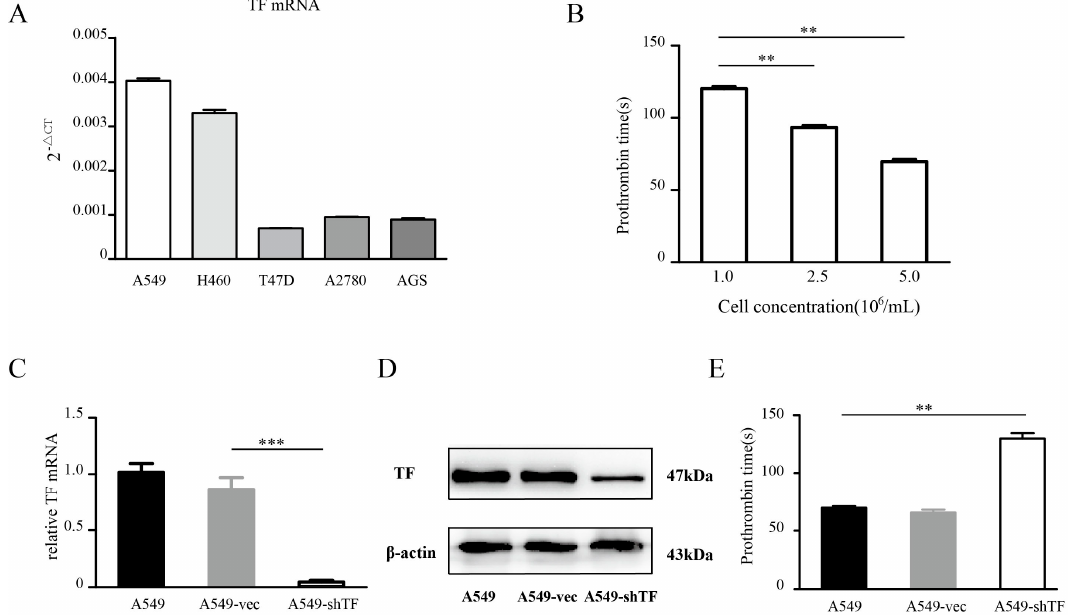
Figure 1. Quantification of tissue factor (TF) and the procoagulant activity of tumor cell. ( A ) TF mRNA was measured in human lung adenocarcinoma cell line A549, breast cancer cell line T47D, ovarian cancer cell line SKOV3, and gastric adenocarcinoma cell line AGS using real-time Polymerase chain reaction (rt-PCR) ( n = 3); ( B ) A549 cells in a series of cell concentrations were tested for their procoagulant activity by measuring prothrombin time after mixing with recalcificated plasma ( n = 3); A549 cells were infected by lentiviruses carrying the shTF gene and empty control. After cell sorting